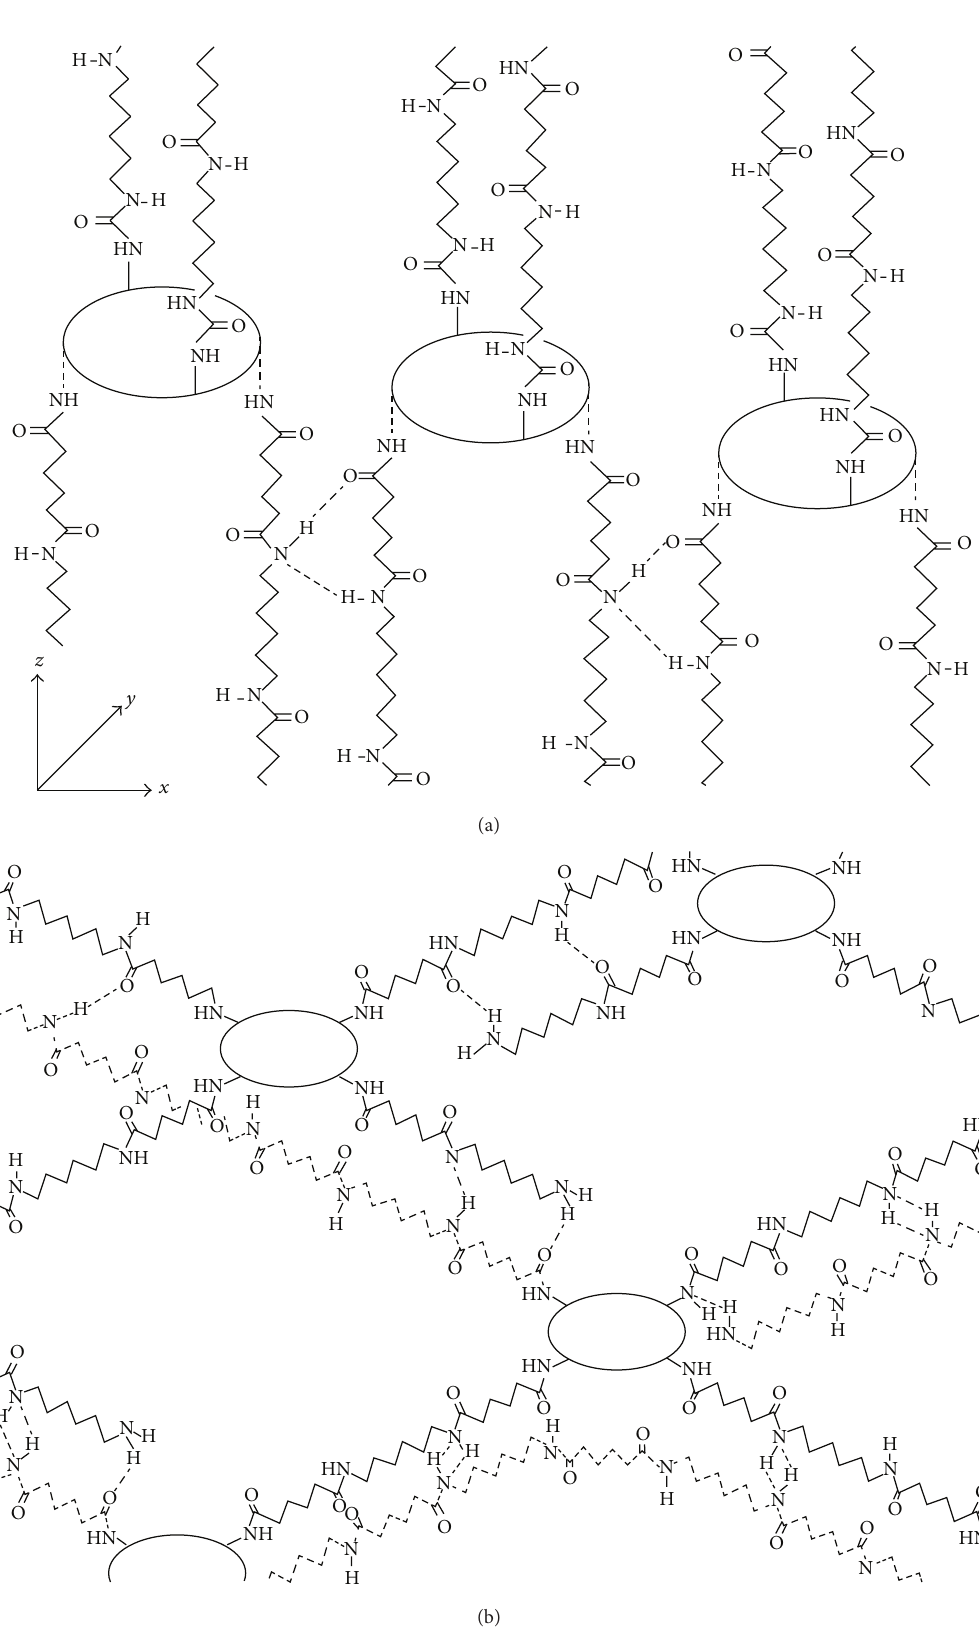
Figure 14: The spatial position of amine groups in ortho - or para -NH 2 substituted tetraphenyl porphyrins induces the growth of different pathways on Nylon 66